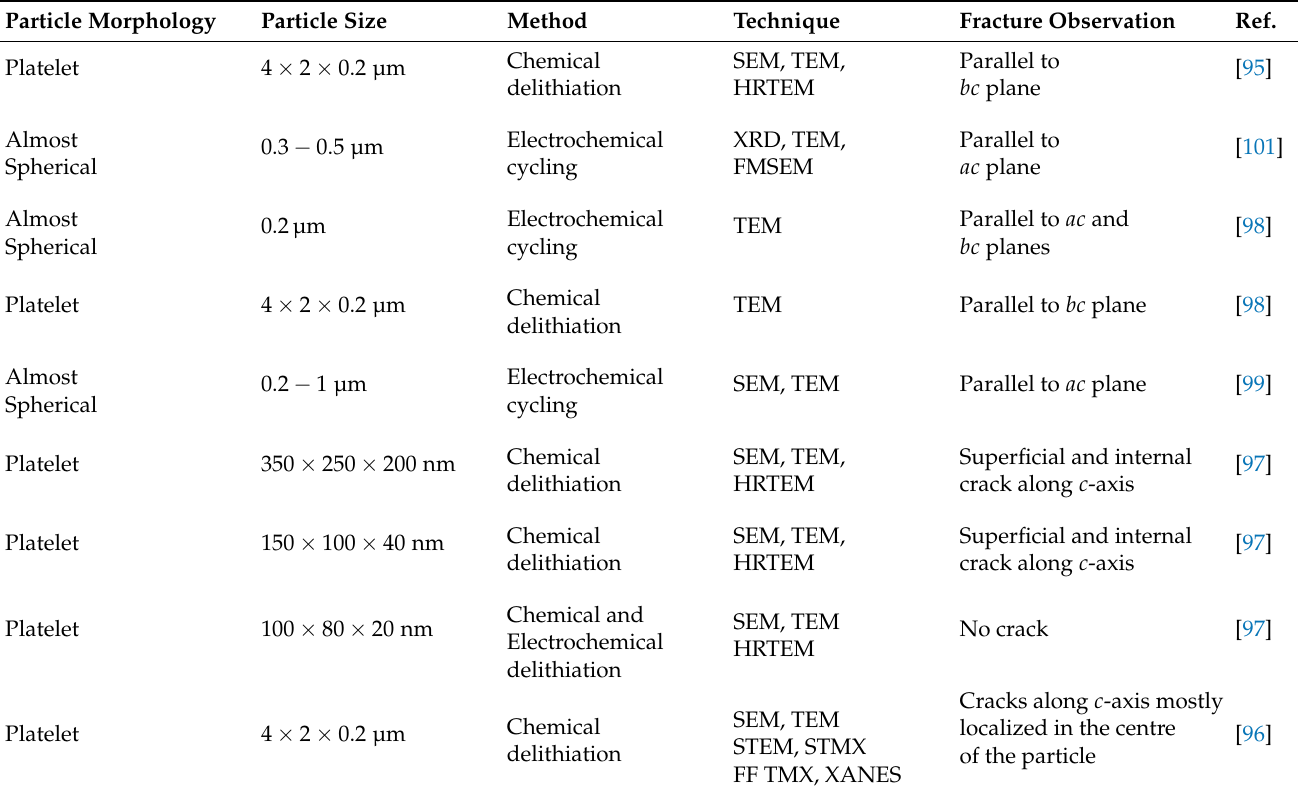
Table 1. Review of the different experimental works performed on the cracking mechanism in LFP grouped according to particle morphology, particle size, (de)lithiation method, and experimental characterization